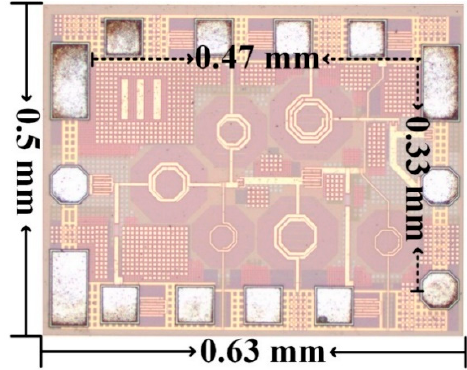
Figure 7. Chip photo of the proposed LNA.